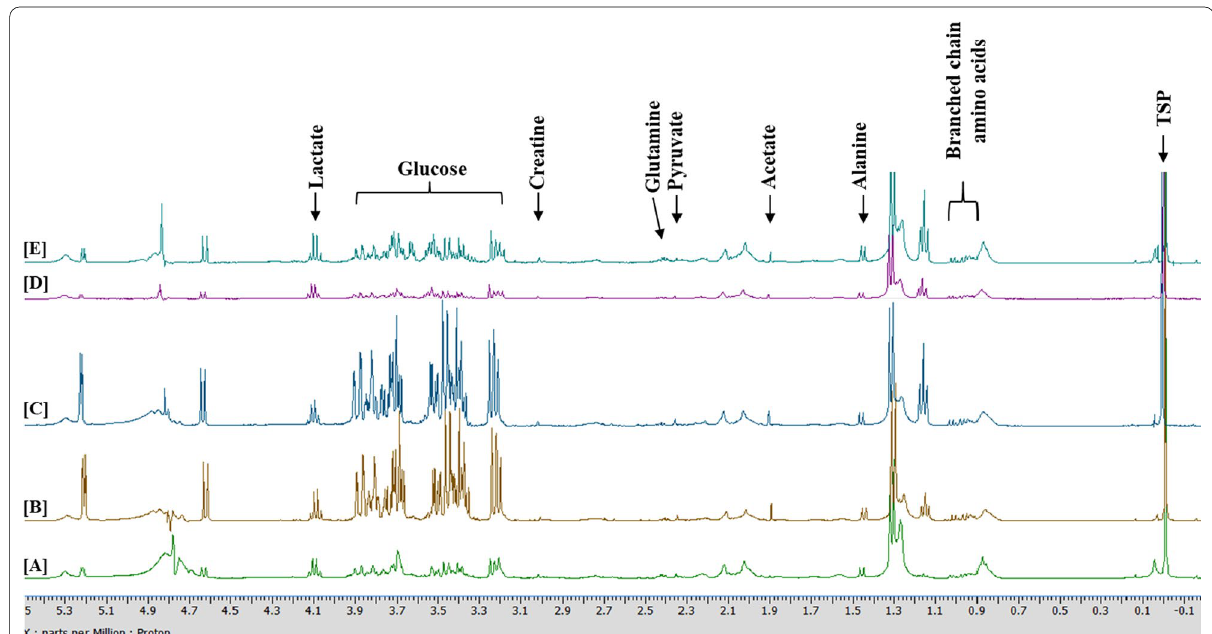
Fig. 1 Representative spectra of serum samples produced by 400 MHz 1D 1 H-NMR from normal rats A , STZ-induced diabetic rats B , STZ DEN-induced diabetic HCC rats C , STZ +